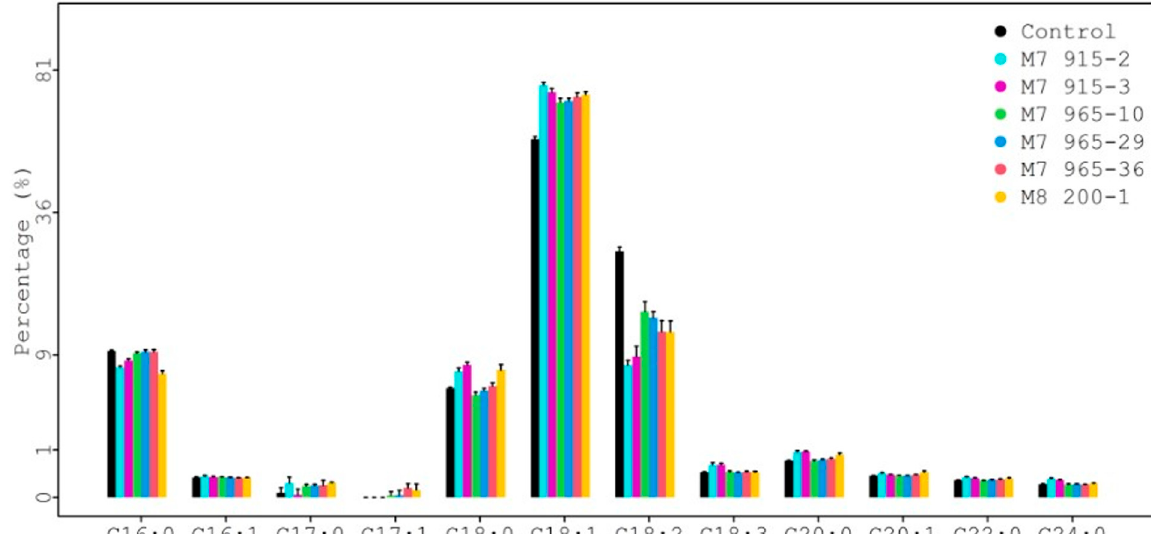
Figure 6. Comparison of fatty acid profiles among mutants at higher generations.